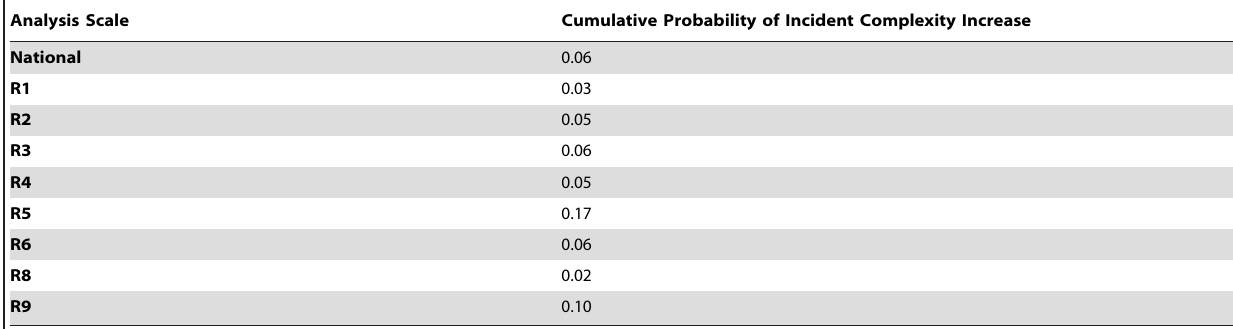
Table 6. Cumulative probabilities of incident complexity increasing (CPI) to Type 1 or Type